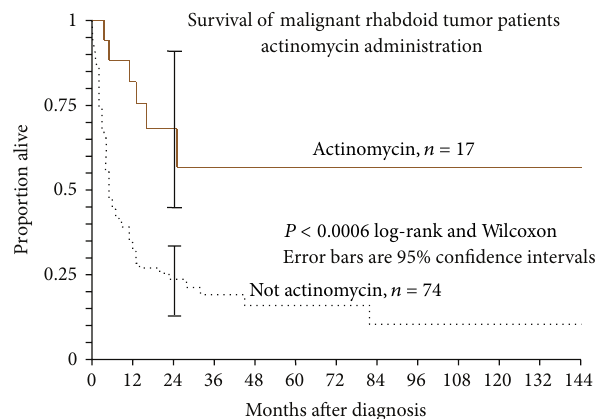
Figure 5: Kaplan-Meier survival estimates of patients treated with and without actinomycin. Actinomycin is associated with a 74% reducedriskofdeath( 𝑃 = 0.0059 )whichheldtrueforallagegroups.